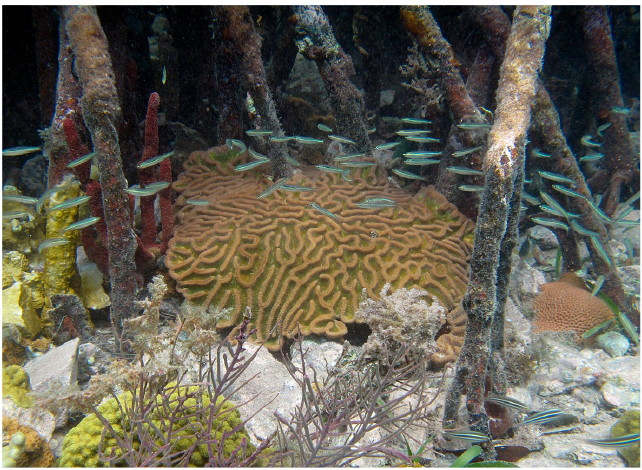
Figure 5. Some of the Colpophyllia natans (above) and Orbicella spp. colonies in the mangroves are close to 1 m across.